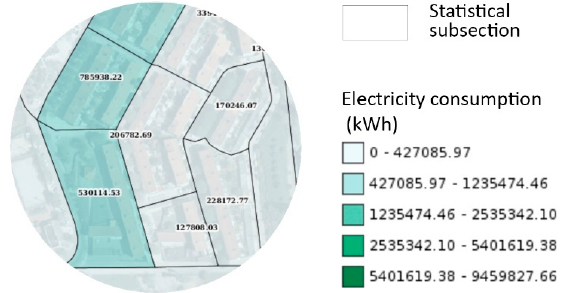
Figure 5. Visualization of data at the statistical subsection level.